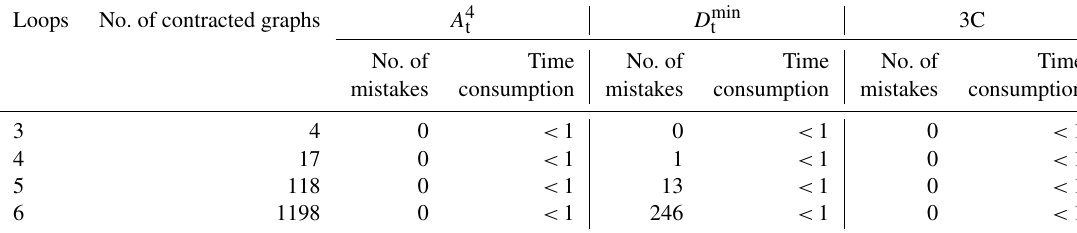
Table 4. Detection results of contracted